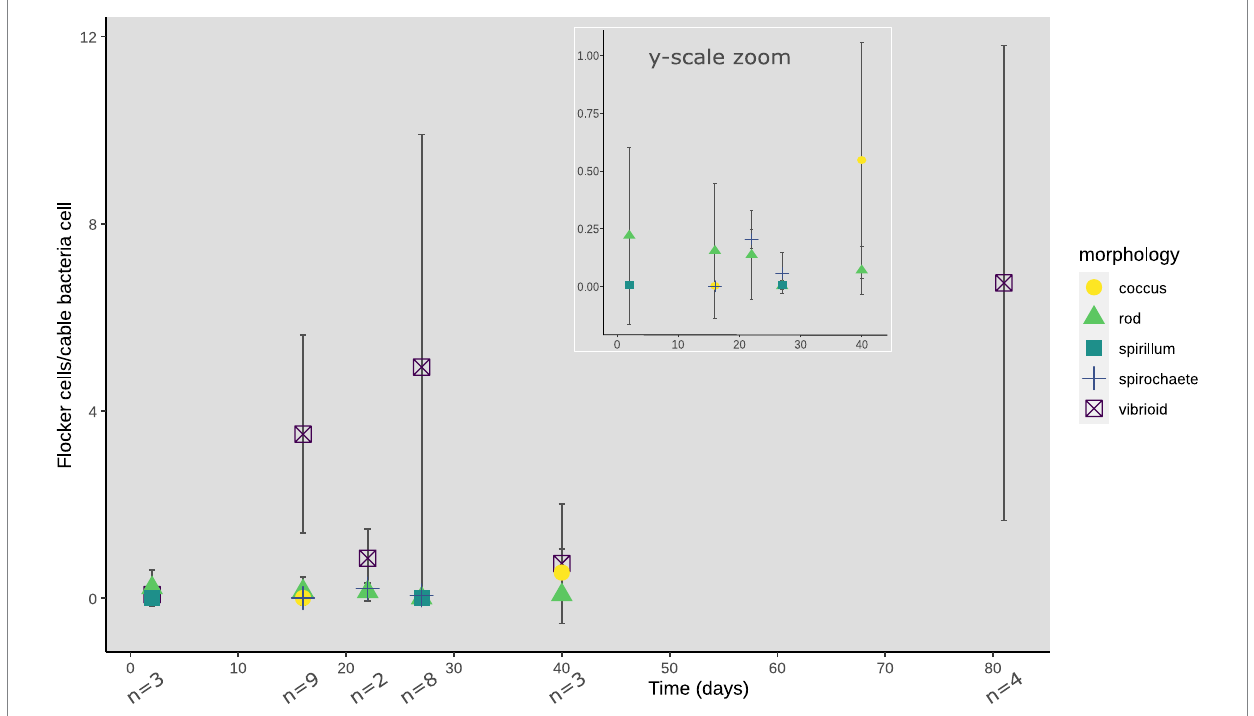
FIGURE 4 Morphologies of flocking cells normalized against cable bacteria cells observed per time point of TS2. Inset shows y-axis zoomed onto 0–1.0 flocking cells/cable bacteria cells until day 40 for low abundancy flocking morphologies. Absence of a morphology-indicator at a certain timepoint depicts zero observed cells of that morphology, with n showing the number of video-frames used for cell